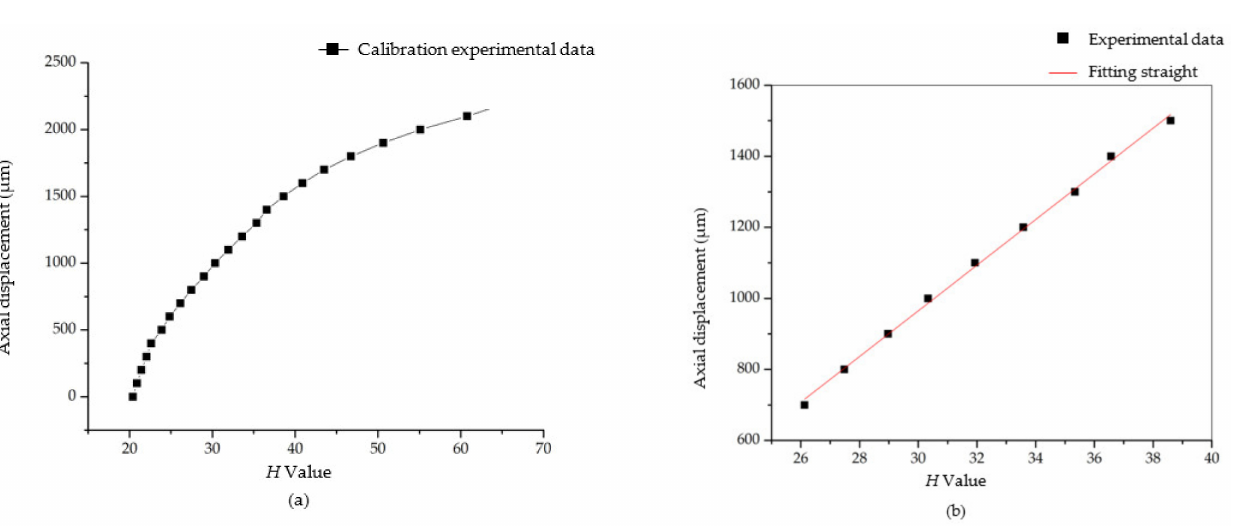
Figure 11. ( a ) Calibration experiment result. ( b ) Linear fitting